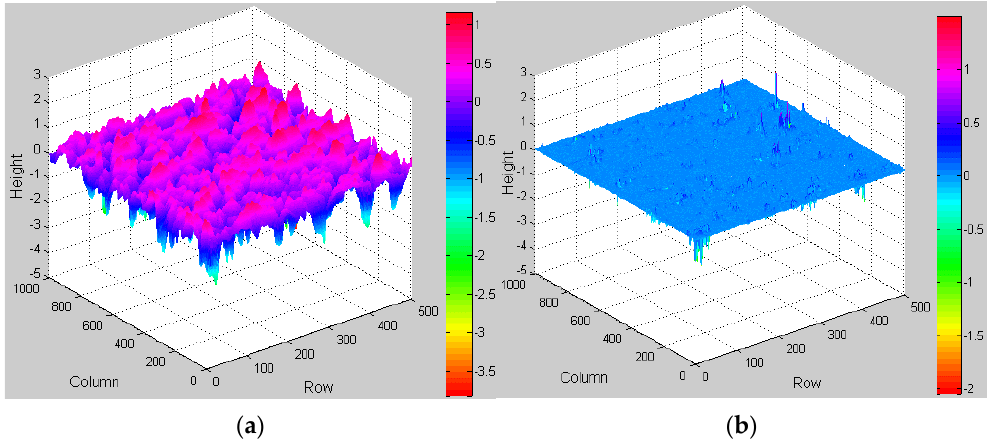
Figure 6. The texture separation results are based on Gaussian filtering. ( a ) Macro-texture. ( b ) Micro-texture.